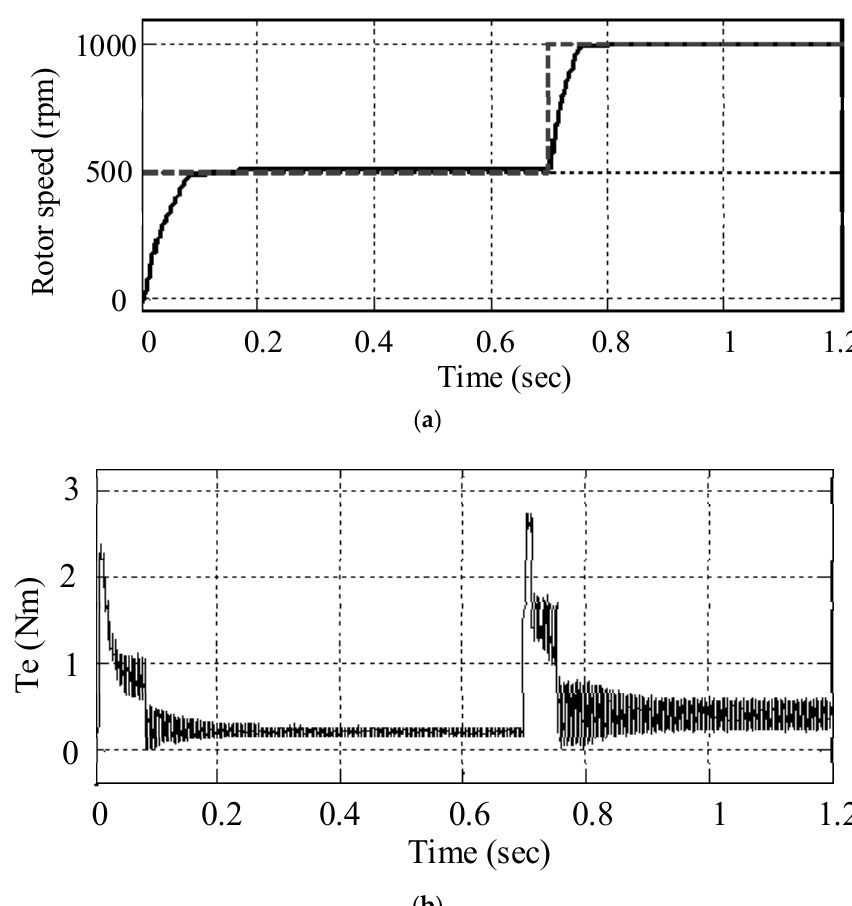
Figure 13. Results of optimal control under the MPTA strategy. ( a ) Rotor speed, ( b ) electromagnetic torque.